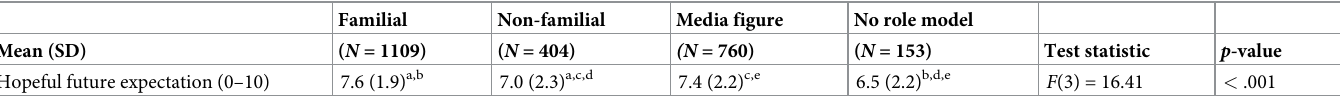
Table 3. Level of hopefulness of future expectations according to role model presence and type.